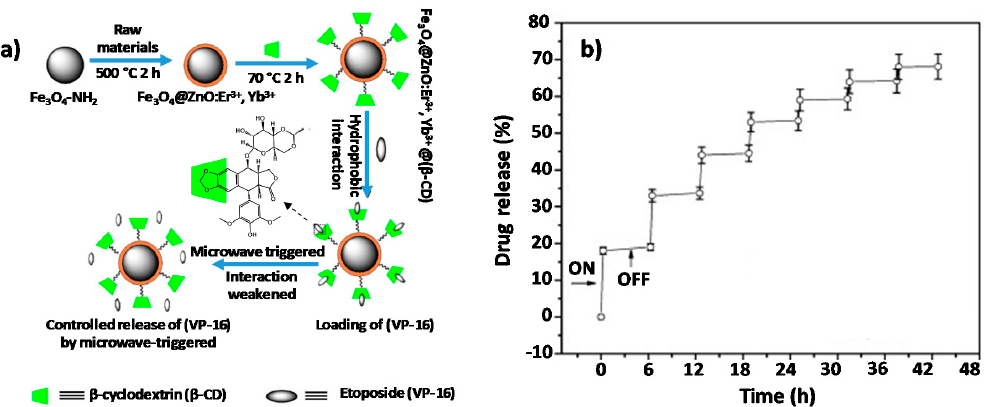
Figure 4. ( a ) Synthesis scheme and mechanism of action of Fe 3 O 4 @ZnO:Er 3+ ,Yb 3+ @ β -CD